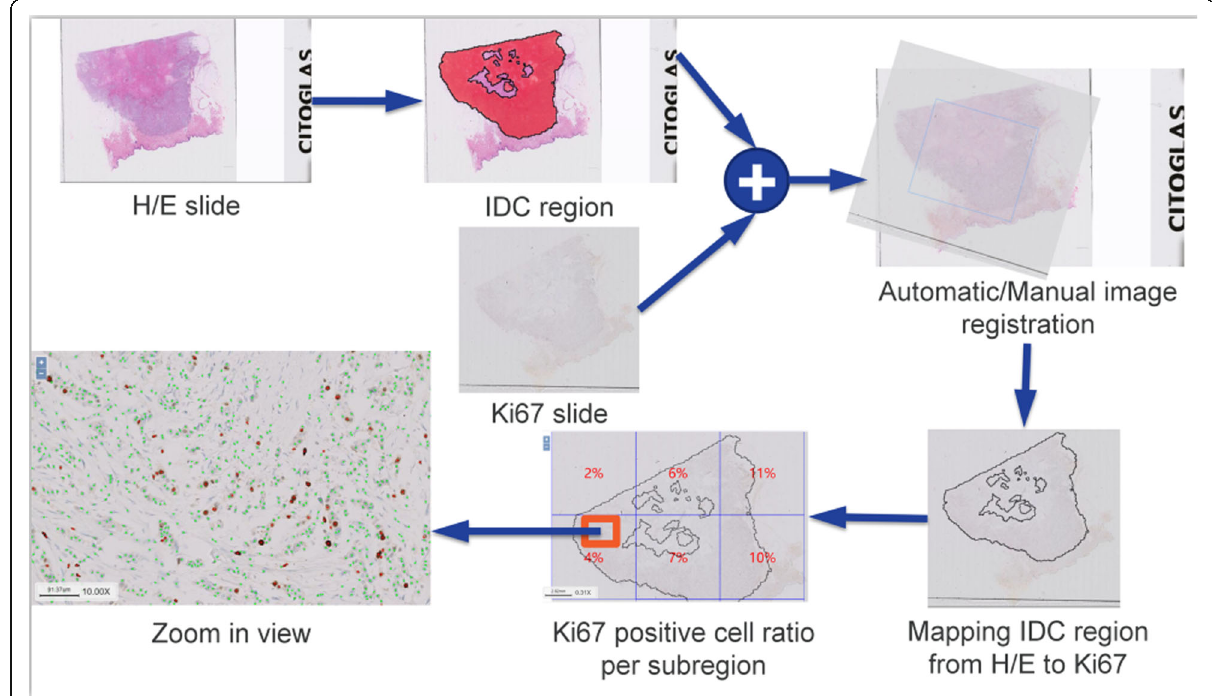
Fig. 1 The flow chart of Ki-67 Automatic Counting Software in breast IDC on whole tissue